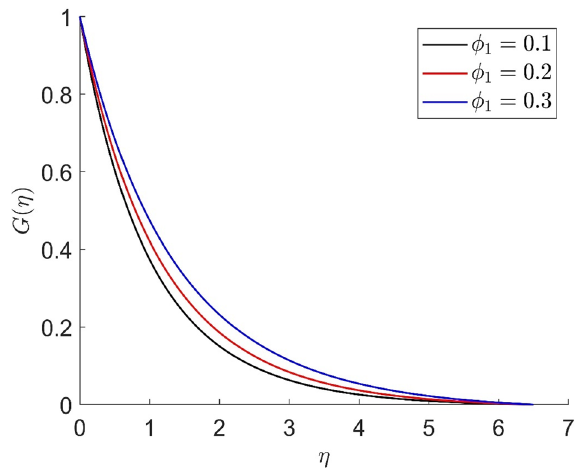
Figure 17. Representation of tangential velocity g (η) for the different values of φ 1 with R = 3, n = 3, v = 0.8, m = 3.5, Pr = 0.9, φ = 0.1, φ 2 = 0.7, β 3 = 0.6, β = 0.3, β 1 = 0.5, β 2 = 0.8, u = 0.5, ξ = 2.5.